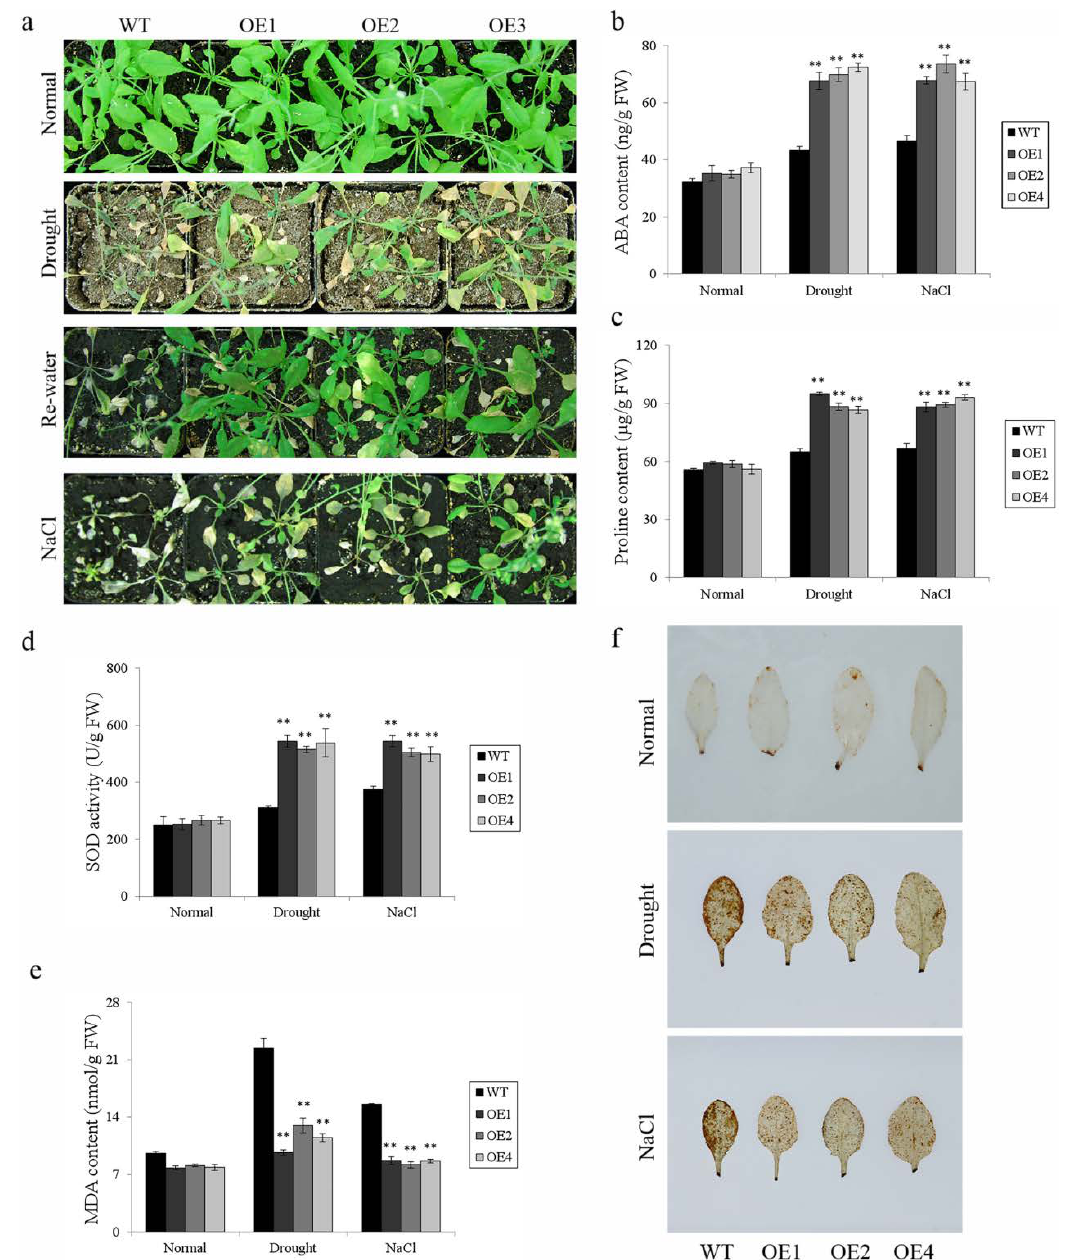
Figure 8. Responses of transgenic Arabidopsis and WT plants grown in pots under drought and salt stresses. ( a ) Phenotypes of transgenic lines and WT grown for 4 weeks under normal condition, 2 weeks under normal condition, and 2 weeks under 300 mM NaCl treatment or 2 weeks under normal conditions and 2 weeks under drought stress followed by 2 days of re-watering; ( b ) ABA content in transgenic lines and WT under the normal or stress condition shown in ( a ); ( c ) proline content in transgenic lines and WT under the normal or stress condition shown in ( a ); ( d ) SOD activity in transgenic lines and WT under the normal or stress condition shown in ( a ); ( e ) MDA content in transgenic lines and WT under the normal or stress condition shown in ( a ); and ( f ) H 2 O 2 content indicated by DAB staining in transgenic lines and WT under the normal or stress condition. Data are presented as means ± SE (n = 3); ** indicate a significant di ff erence at p <